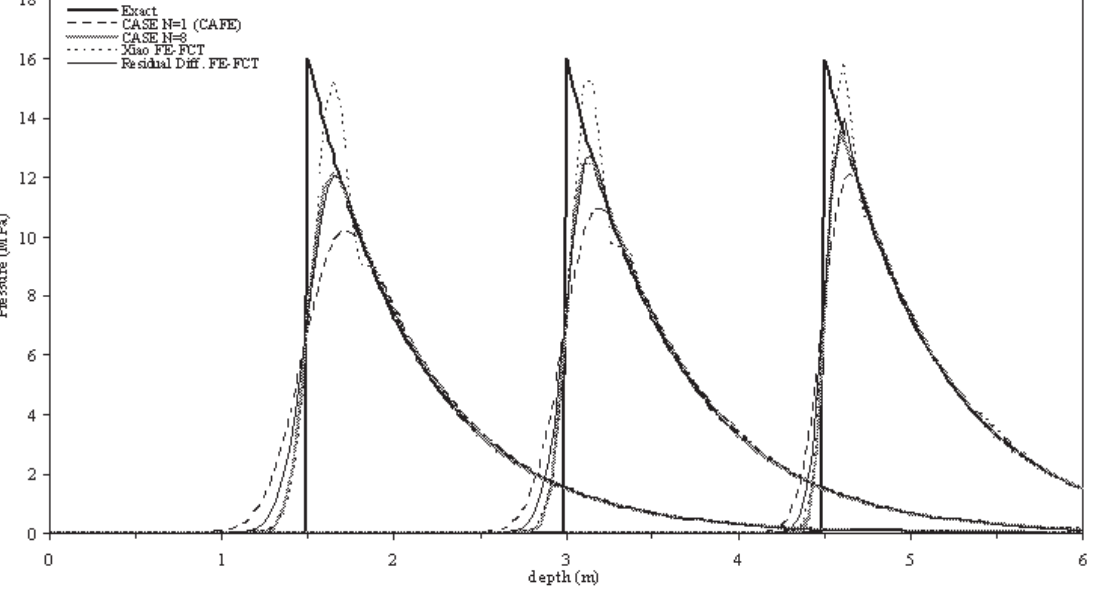
Fig. 2. Shock wave in a fluid bar results for 241 DOF mesh at times (from right to left) t = 1 ms, 2 ms, and 3 ms. of peak pressure. Also like the 81 DOF case both the 8th order CASE and Xiao’s FE-FCT algorithm solutions have the sharpest wave